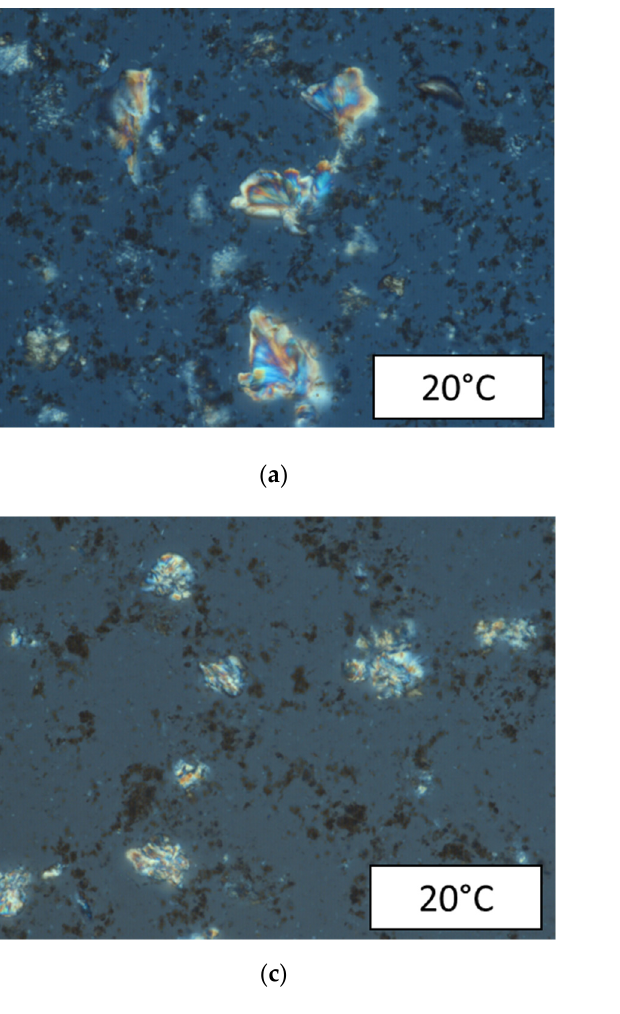
Figure 8. CPM images at 20 °C of oils ( a ) 2A-PI2 and ( b ) 3A-PI2, ( c ) 2A-PI3, and ( d ) 3A-PI3. Wax crystals were not observed for oil 1A-PI2 or 1A-PI3 under the same conditions.